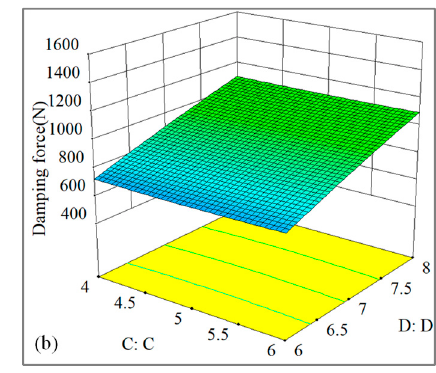
F vs. A and B; and ( b ) damping d